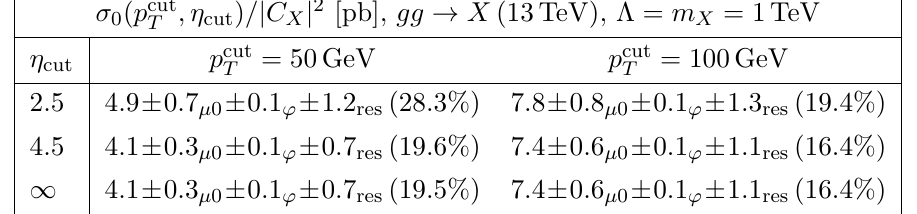
; (cid:17) cut ) for gg X for m X = 1 TeV at NLL 0 +NLO for di(cid:11)erent T ! (cid:1) ’ (cid:1) res . The absolute cross section (cid:8) (cid:8) . 1